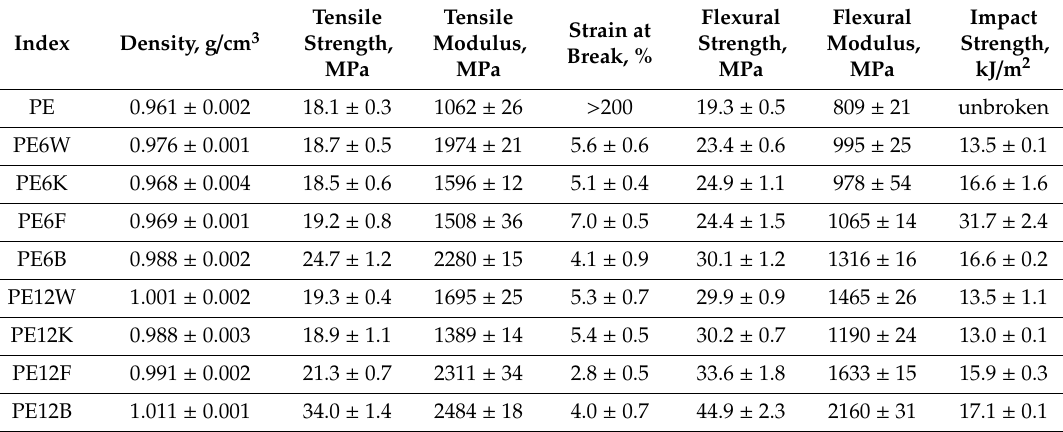
Table 4. Basic mechanical properties of tested